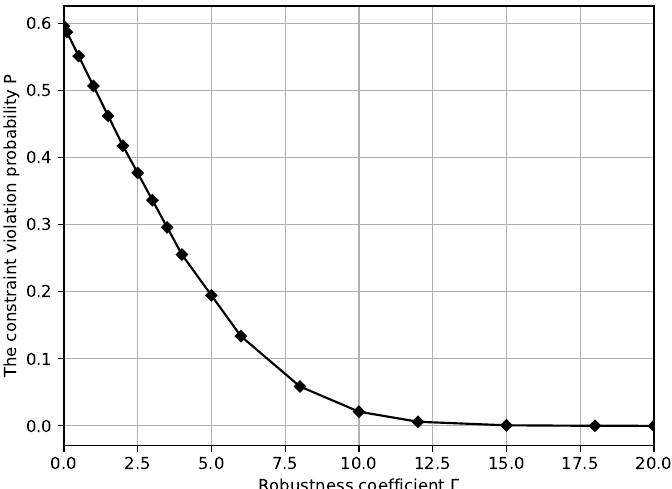
Figure 2. The constraint violation probability P versus different robustness coefficients, Γ .